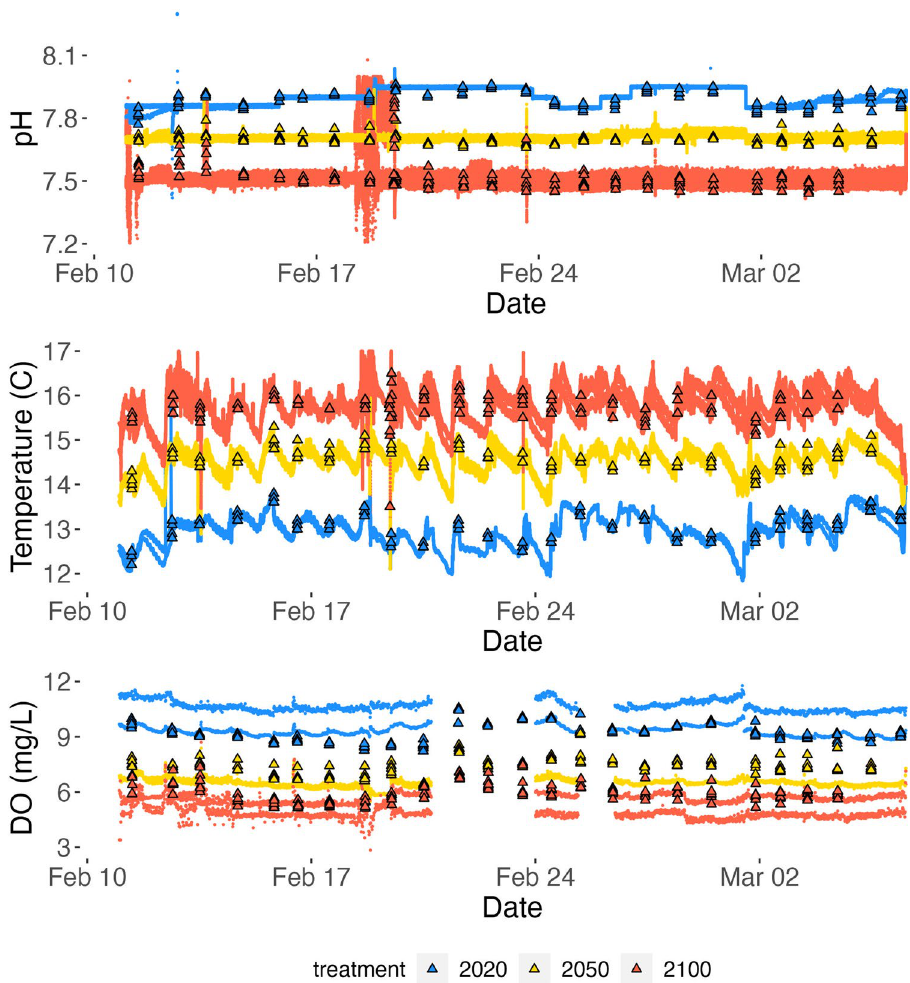
Figure 5. Temperature, pH, and DO values measured over the duration of the experiment for the year 2020 (blue), year 2050 (yellow), and year 2100 (red) treatments. Temperature and pH values were measured every 15 s by Durafet sensors in the header tanks (lines) and once daily by YSI sensors in the replicate aquaria (triangles). DO concentration was measured by Vernier sensors every 15 min in the header tanks (lines) and once daily by YSI sensors in the replicate aquaria (triangles).